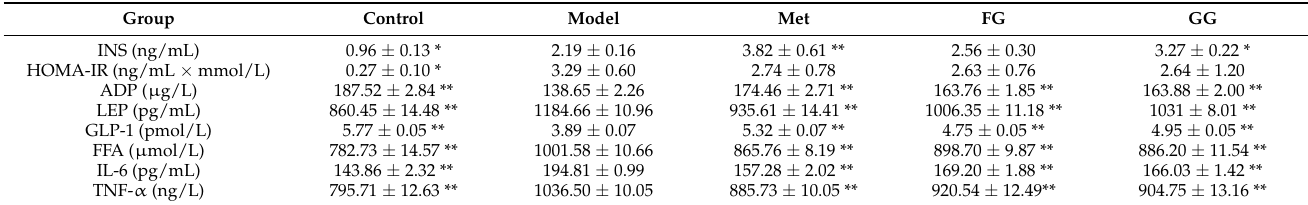
Table 1. Effects of Pueraria polysaccharides on the biochemical values of db/db.